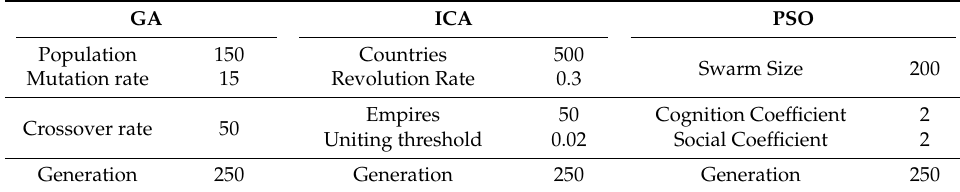
Figure 5. Graph cost for 250 iterations in the 250GEN_5IN model. Table 6. Applied GA, ICA, and PSO parameters. Table 6. Applied GA, ICA, and PSO parameters.